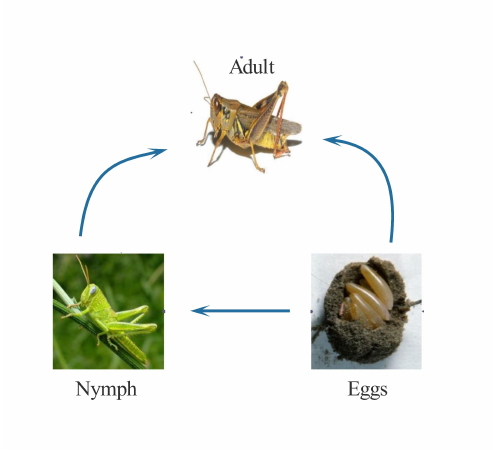
Fig. 5. The life cycle of grasshoppers